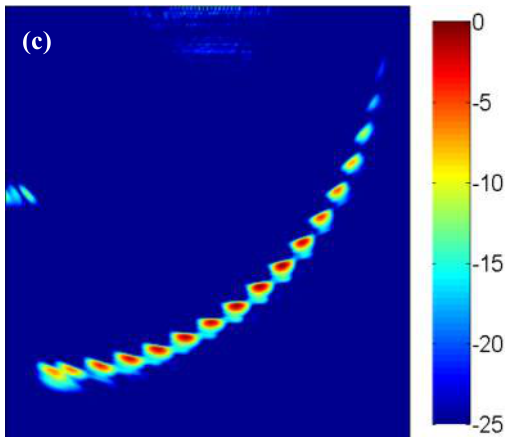
Figure 9. The results with different imaging methods ( a ) ADSGA sparse-TFM; ( b ) ADSGA-NEDI sparse-TFM; ( c ) TFM.